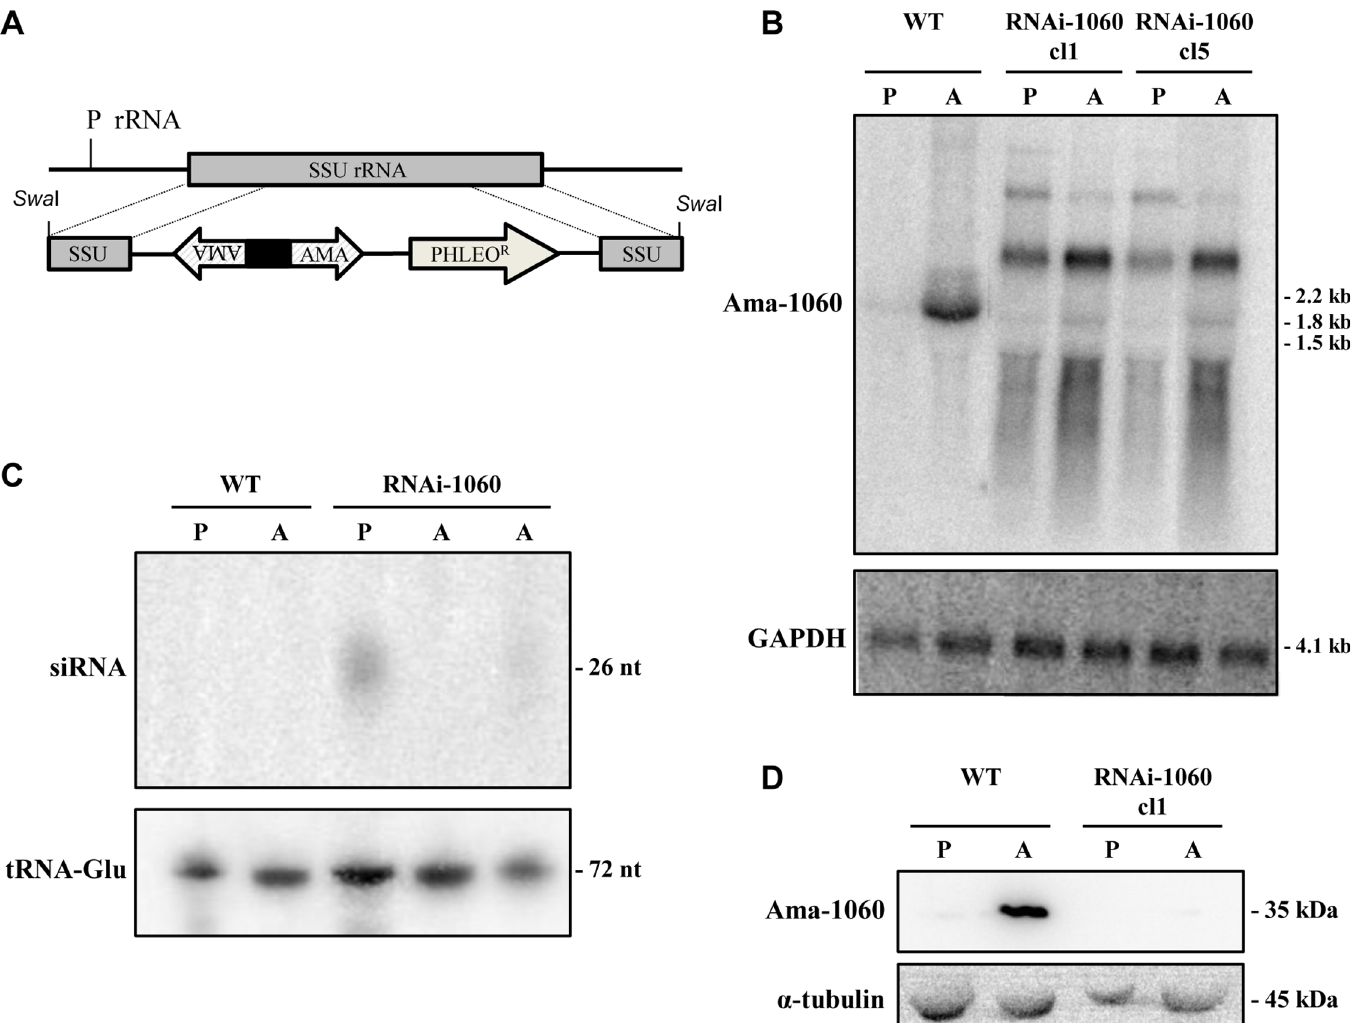
Fig 6. RNAi knockdown of amastin genes in Leishmania braziliensis . (A) The plR1-Phleo plasmid containing two opposite amastin fragments with a stem-loop stuffer fragment (black box), Phleomycin resistance (gene PHLEO) and the rRNA promoter (P rRNA) is shown integrated into the SSU rRNA locus of Leishmania (gray box). (B) Northern blot analyses of RNA isolated from (P) promastigote and (A) axenic amastigotes from wild type L . braziliensis (WT) and two cloned cell lines of L . braziliensis transfected with a construct that generates δ -amastin dsRNA named RNAi-1060-cl1 and cl5. The blots were probed with a 32 P-labelled DNA fragment corresponding to the LbrM.08.1060 amastin gene. (C) Low-molecular-weight RNAs isolated from promastigotes and amastigotes from WT L . braziliensis as well as from promastigotes from RNAi-1060 cl1 and amastigotes from the two cloned cell line transfected with amastin dsRNA constructs (RNAi-1060 cl1 and cl5) were fractionated on a 15% polyacrylamide gel and probed with a mixture of 32 P-labelled oligonucleotide probes corresponding to the full length LbrM.08.1060 amastin gene. siRNA indicates the position of small interfering RNA bands that hybridized with δ -amastin oligonucleotide probes, which co-migrate with a 26 nt DNA molecular weight marker. Hybridization of the same blot with a probe corresponding to the L . braziliensis Glu-tRNA is also shown as a loading control. (D) Total protein extracts from the cloned cell RNAi-1060 cl1 was analyzed by western blot using an antibody generated against the recombinant Ama1060. The same blot was incubated with anti- α -tubulin as a loading control.